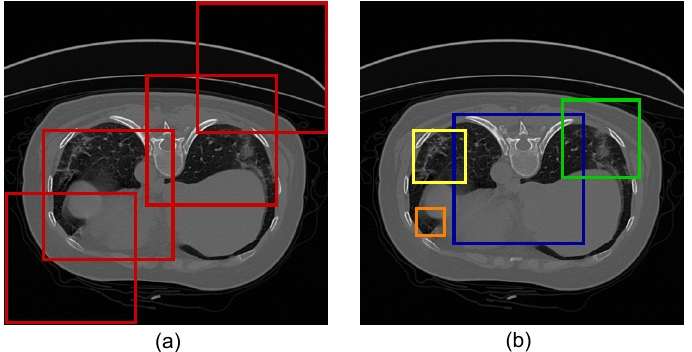
Figure 7. Illustration of receptive fields. ( a ) Receptive fields in the same layer with the same size kernel that capture more background pixels, and ( b ) receptive fields with varying dilation rates (shown in four different colored boxes) which capture the small and relevant